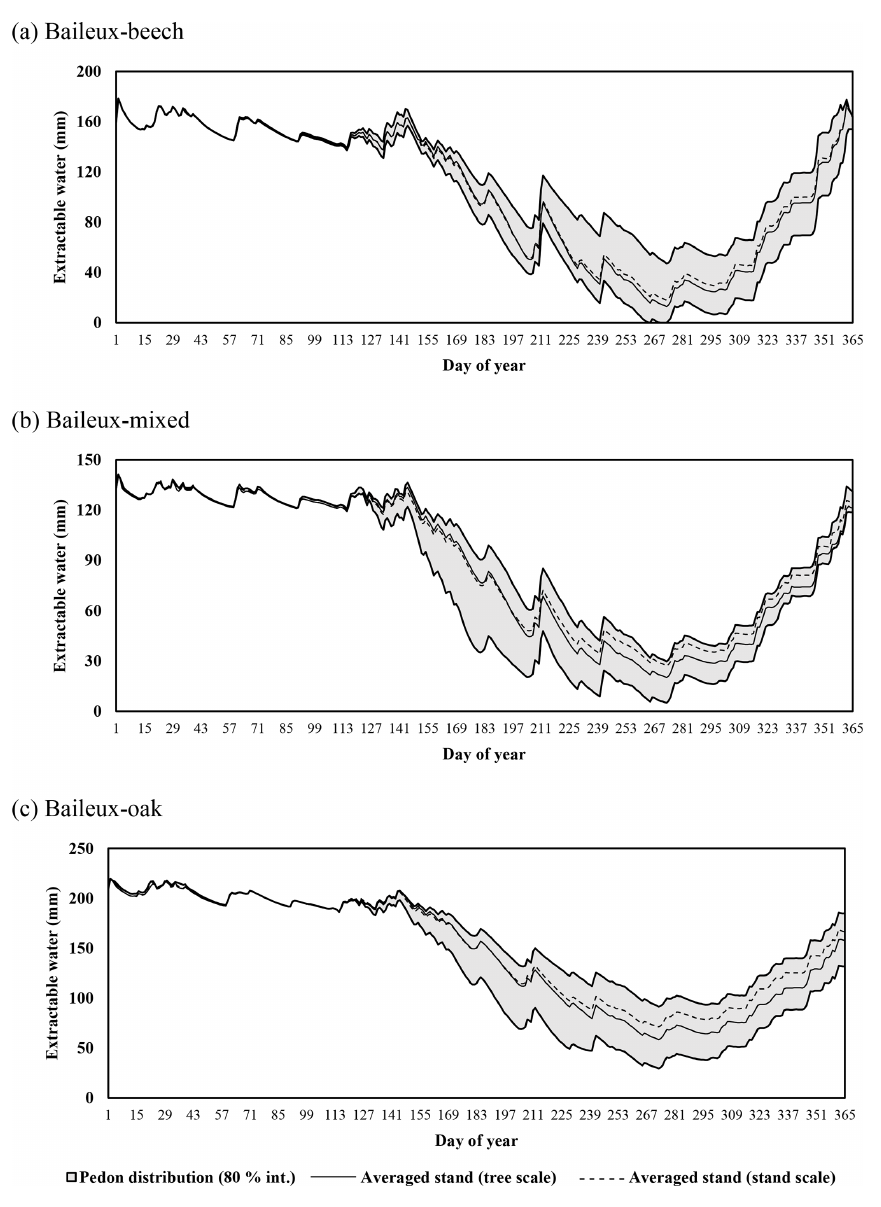
Figure C1. Temporal dynamics of soil-extractable water simulated with the tree approach in the three stands of Baileux for 2003. The shaded area represents the 80% confidence interval of the values obtained for the various pedons. For comparison, the mean extractable water calculated with the stand approach is represented with a dashed